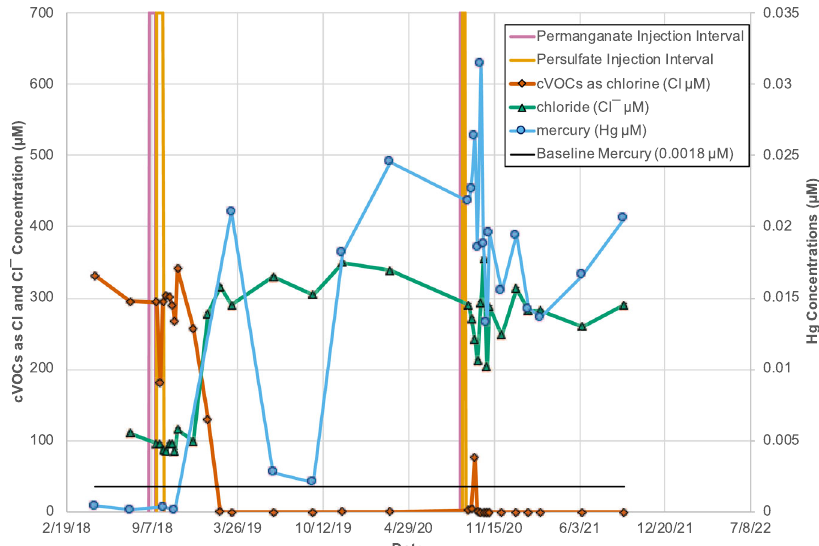
Fig. 6 Concentrations of cVOCs as chlorine, chloride, and mercury in WSM001CC showing persistent high chloride concentrations that suggest an alternative continued chloride source (e.g., DNAPL) in addition to chloride from the depleted aqueous phase cVOCs. Reddish purple and orange lines indicate beginning and end of permanganate and persulfate solution injections, respectively. Vermillion line with vermillion diamonds mark concentrations of cVOCs as chlorine, which is depleted after oxidant injection. Bluish green line with large bluish green triangles mark chloride concentrations, which are persistently higher than baseline and suggest an additional chloride source apart from aqueous phase cVOC destruction. Sky blue line with sky blue circles mark concentrations of mercury, which signi fi cantly increase after the second oxidant injections. Black line indicates average baseline mercury concentration. Only two dates (9/25/18 and 6/9/21) were analyzed in duplicate for chloride and the data ranges are too small to see in this fi gure (range 4 µ